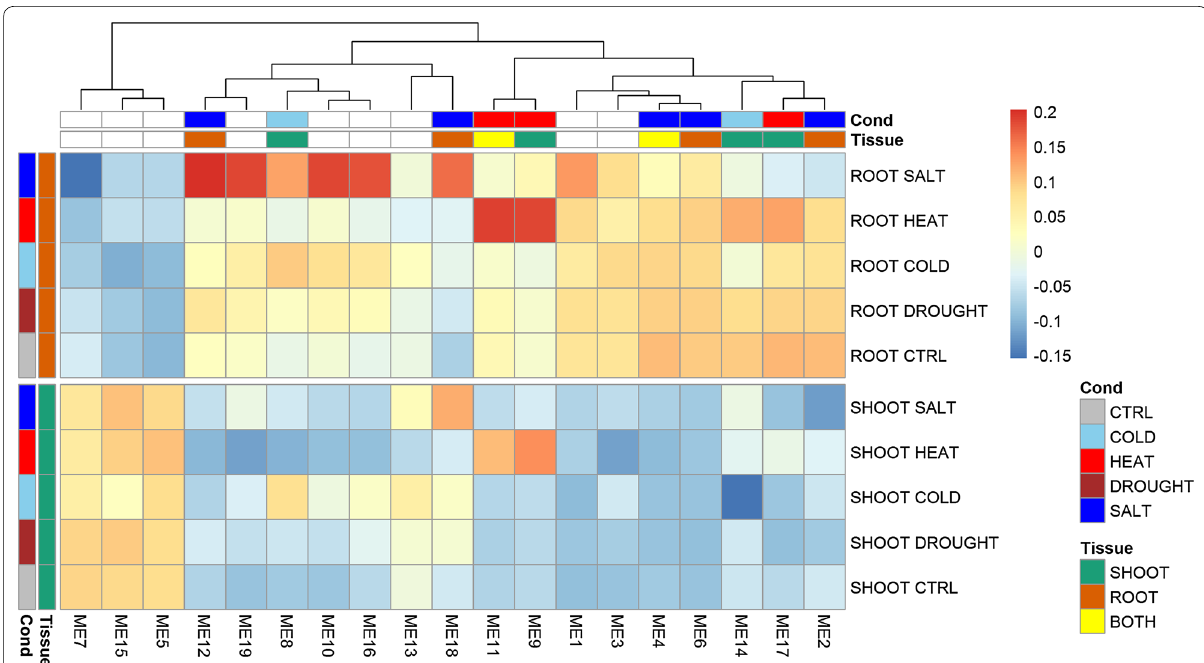
Fig. 2 A heatmap consisting of 19 gene modules, 5 stress conditions, and 2 tissue types. This heatmap was consisting of 19 gene modules (M1 to M19), 5 stress conditions (cold, heat, salt, drought, and control), and 2 tissue types (root and shoot